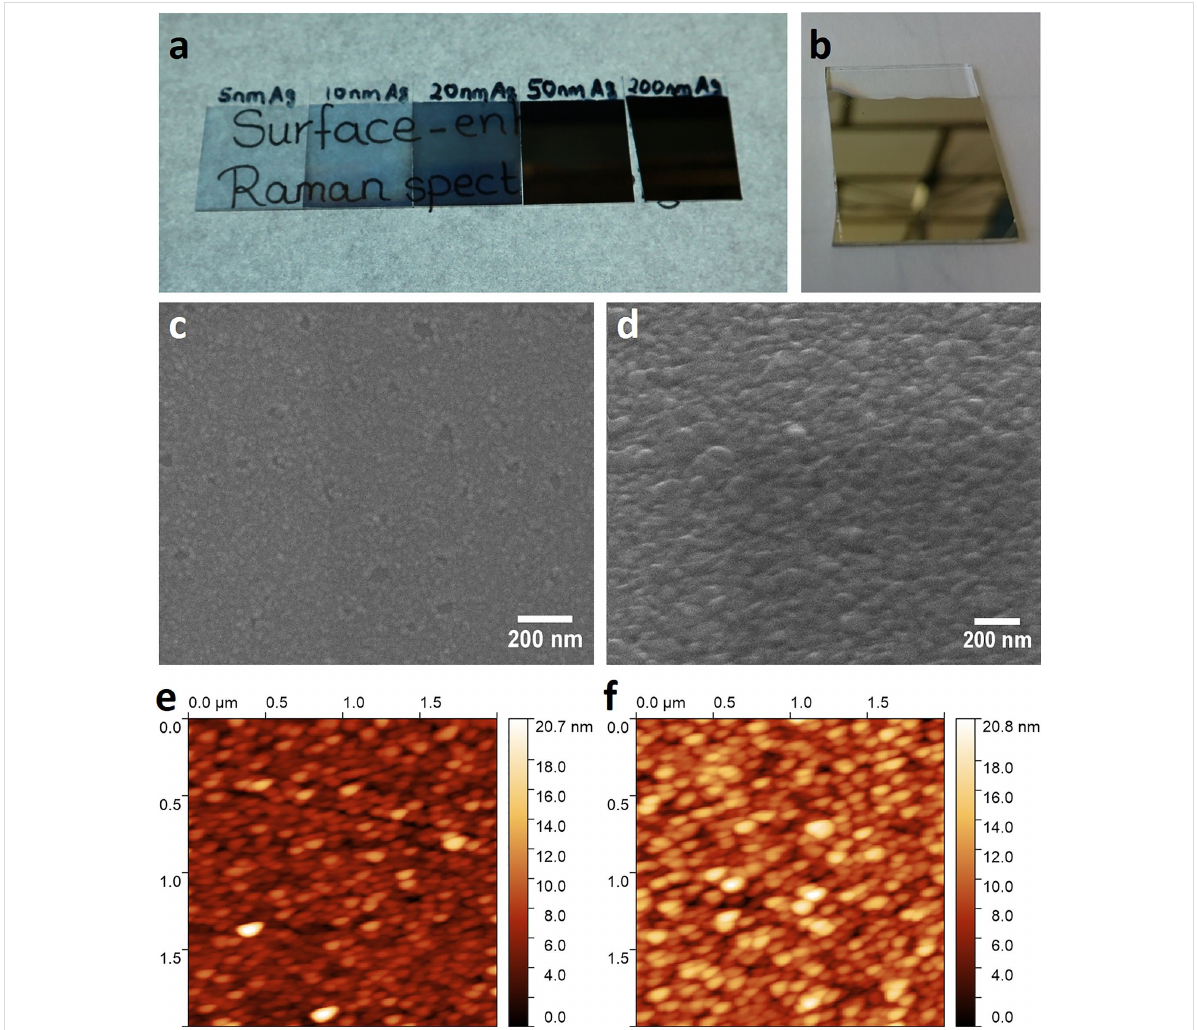
Figure 1: (a) Photograph of sputtered silver films on glass substrates with different thicknesses. From left to right: 5, 10, 20, 50 and 200 nm. (b) Photograph showing the mirror-like appearance of the 200 nm silver film. SEM images of (c) 10 nm and (d) 200 nm silver films. AFM images of (e) 10 nm ( R q = 2.02 nm) and (f) 200 nm ( R q = 2.79 nm) sputtered silver